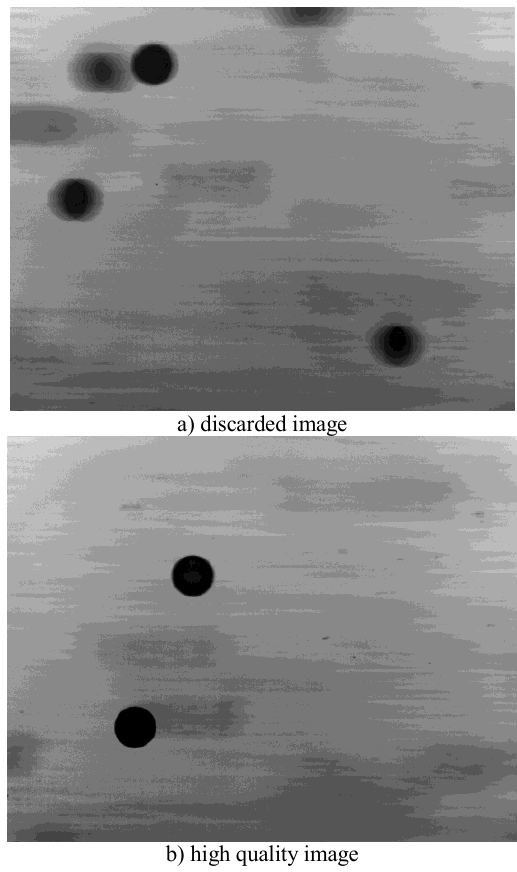
Fig. 3. Image analysis: quality of captured